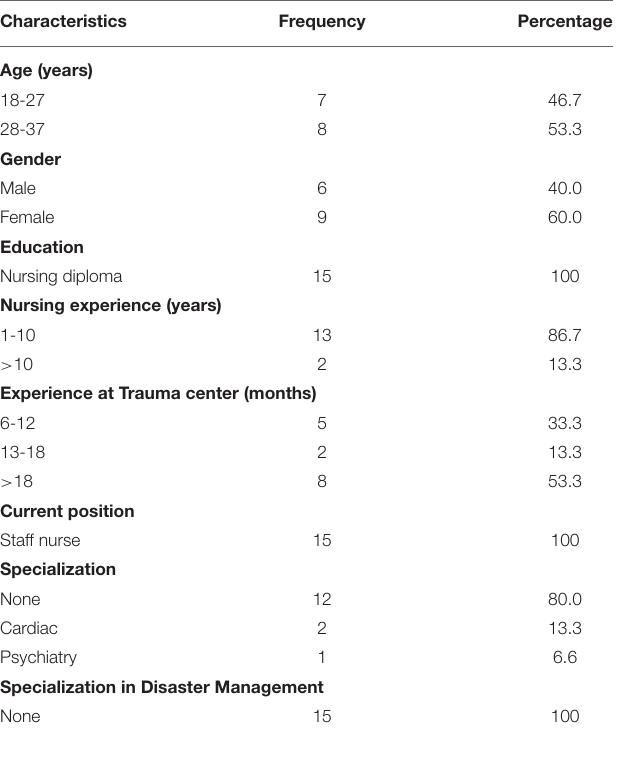
TABLE 1 | Demographic characteristics of the respondents.